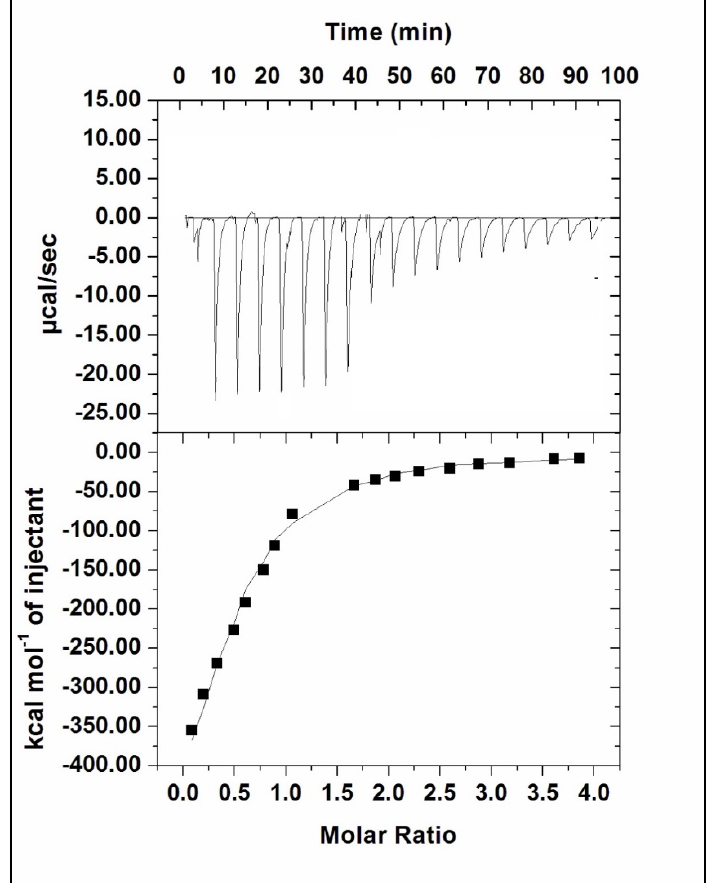
Figure 9. ITC isotherm of Rv1636- β -Amyrin system: The sample cell was filled with 20 µM Rv1636, while the syringe was filled with 500 µM β -Amyrin. The figure was obtained as one model binding site.